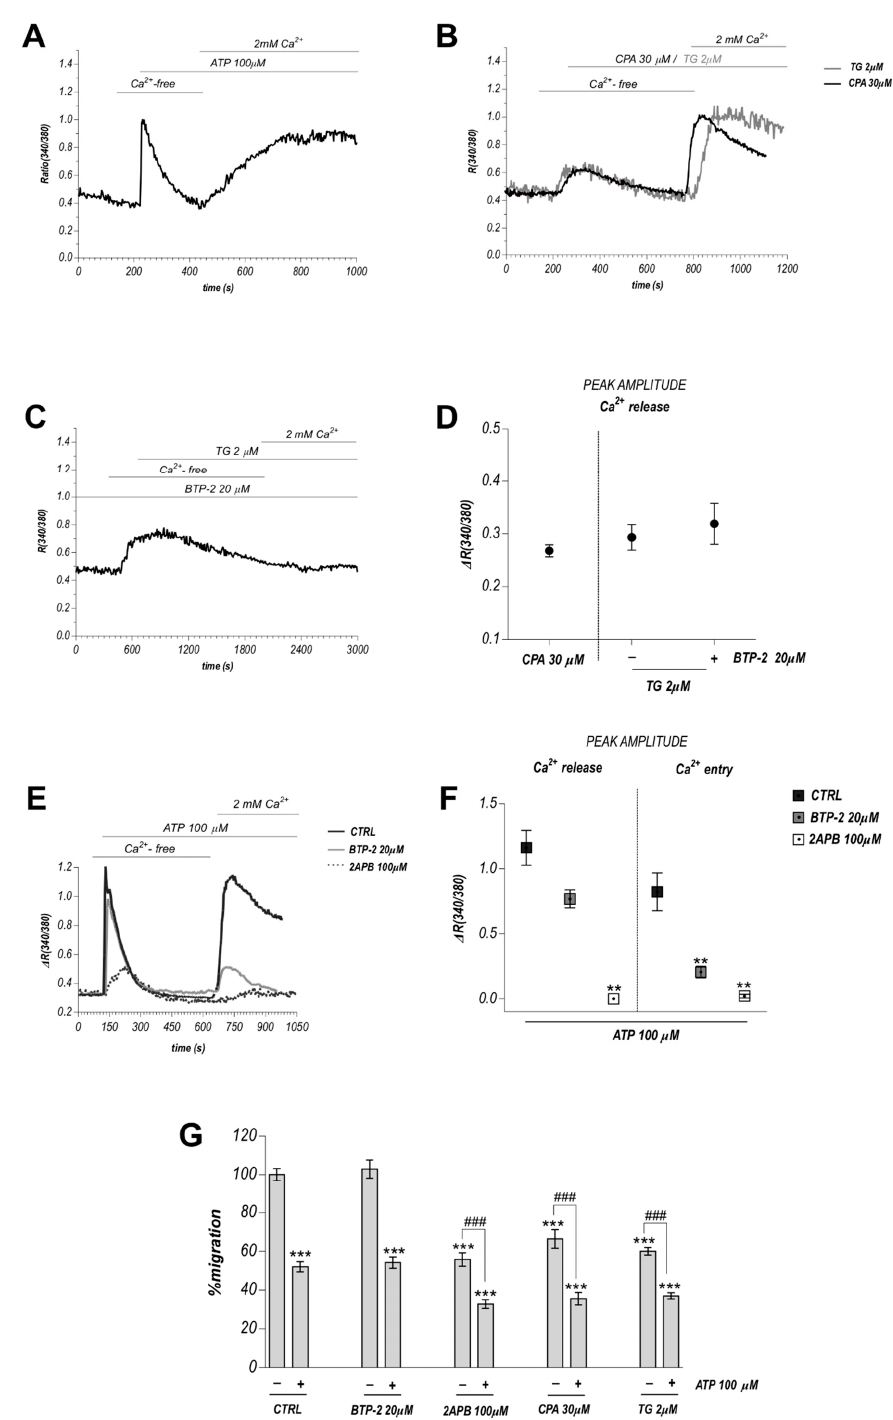
Figure 2. Calcium release, SOCE and relative involvement in anti-migratory action of high ATP. ( A , B ) Representative average traces obtained from the application of the ’Ca 2 + add-back’ protocol upon treatment with 100 µ M ATP ( A ), 30 µ M CPA or 2 µ M TG. ( C ) Preincubation with 20 µ M BTP-2 (20 min) completely abolished TG-induced SOCE. Representative average trace. ( D ) Quantification of the previous experiments. Data are expressed as mean ± SEM. ( E ) E ff ect of preincubation with 20 µ M BTP-2 or 100 µ M 2-APB on ATP-induced calcium response. Representative average traces. ( F ) Quantification of the previous experiments. Data are expressed as mean SEM. ** p -value < 0.005 vs. CTRL. ( G ) BTEC migration evaluated by scratch wound healing measurements. E ff ects of CPA, TG, BTP-2, 2-APB. Data are expressed as percentage of migration at 8 h, normalized to the corresponding control (CTRL) and expressed as mean ± SEM. Mann-Whitney test: *** p -value < 0.0005 vs. CTRL; ### p -value <